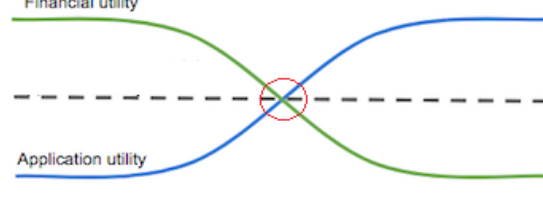
Figure 1. A graphical depiction of the intersection of application utility and financial utility as time progresses 2. Literature